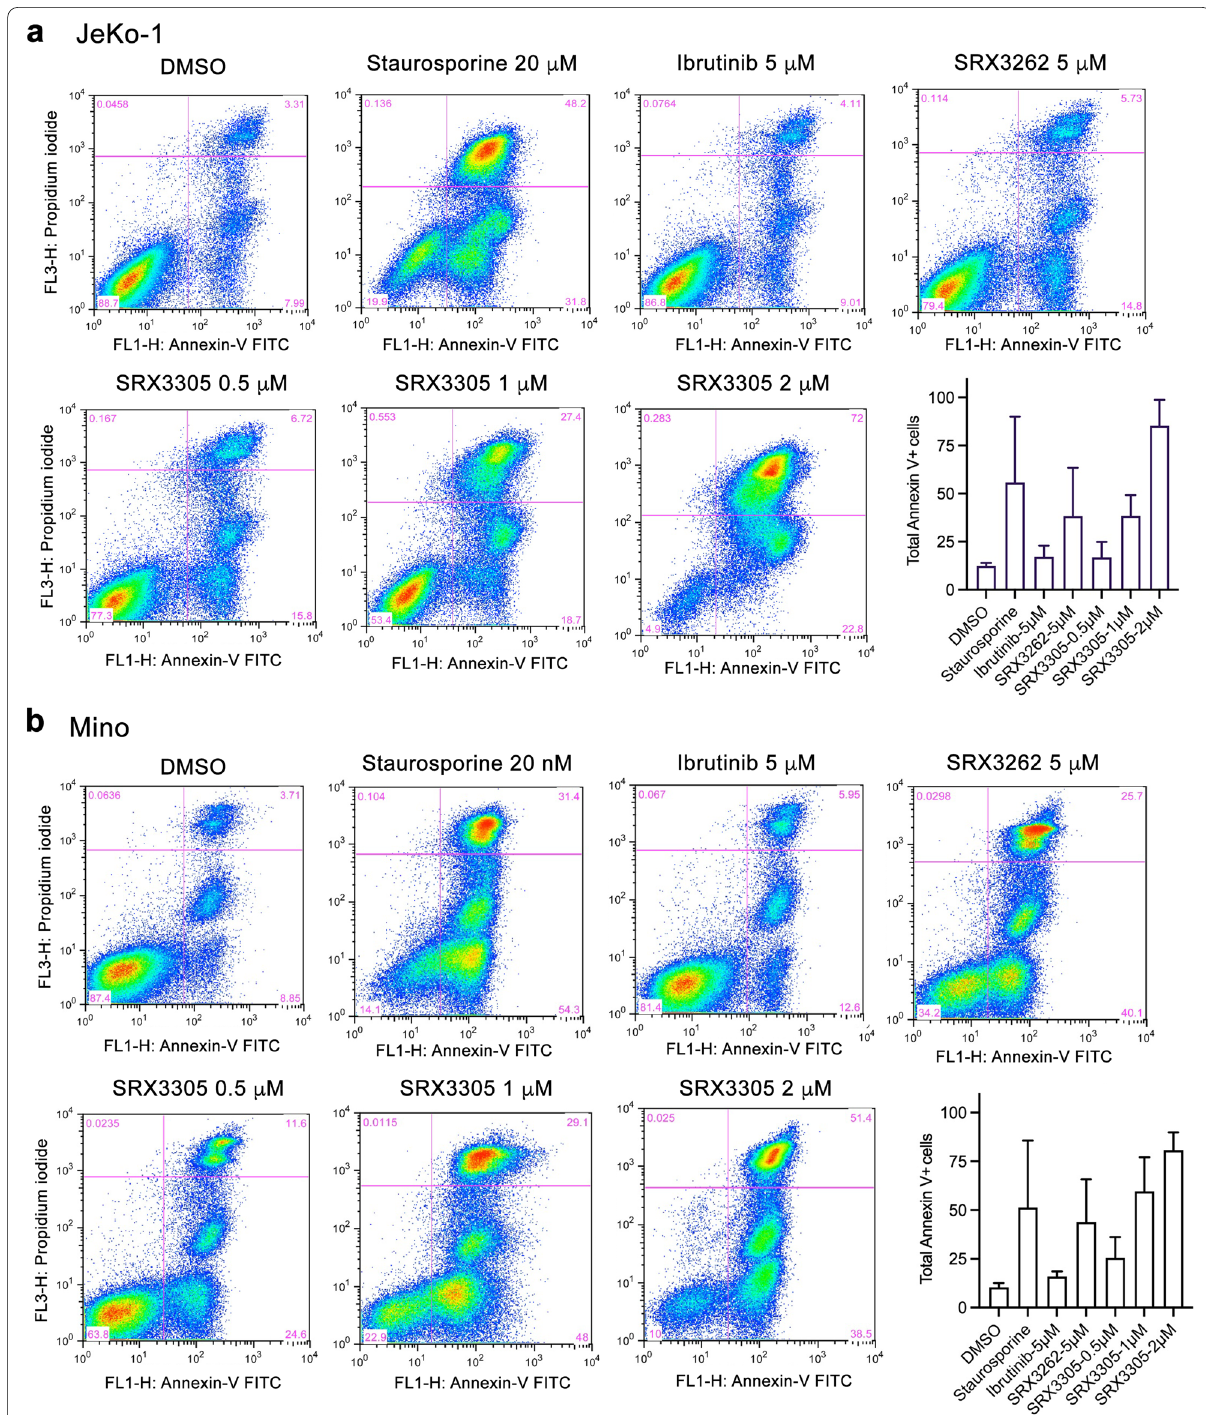
Fig. 4 SRX3305 induces apoptosis and cell cycle arrest. a , b Flow cytometry analysis of apoptosis induced in the JeKo‑1 ( a ) and Mino ( b ) MCL cell lines treated with control (DMSO) or the inhibitors Staurosporine, Ibrutinib, SRX3262 and SRX3305 and assessed after 24 h by evaluating the total percentage of Annexin V/ Propidium Iodide positively stained cells. Histograms show % apoptotic cells (Annexin V positive cells). Experiments were independently performed in duplicate (see also Supplementary Figs. 4 and